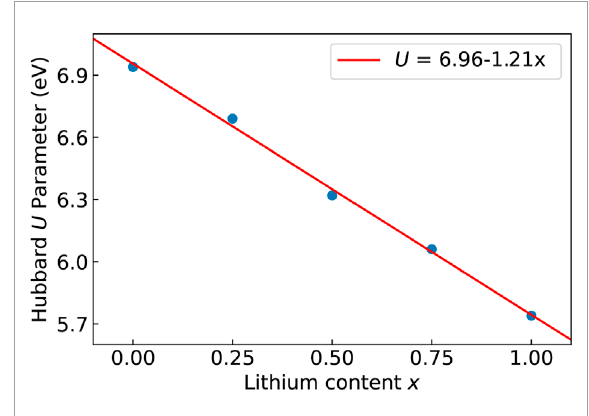
FIGURE 3 The Hubbard U parameter obtained with the linear response approach as a function of Li content. The linear fit to the data is presented in upper right corner.